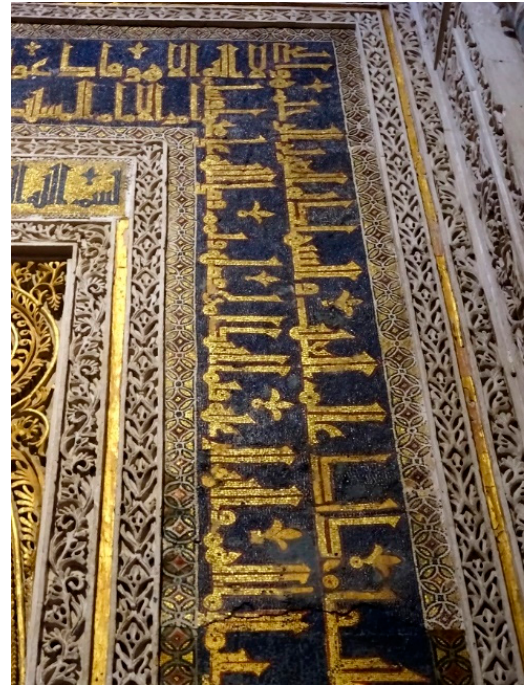
Figure 8. Great Mosque of Cordoba. Detail of the mosaic decoration on the mihrab façade. © Photo took by author.